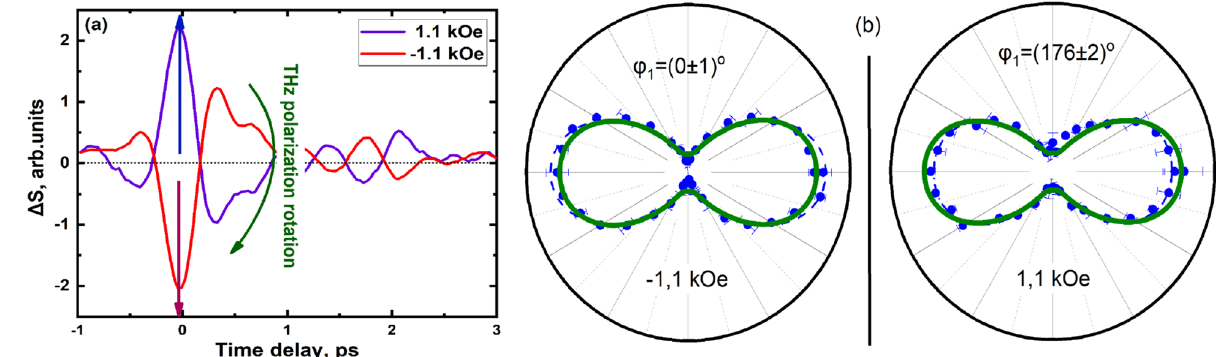
Figure 5. ( a ) Time-domain profile of the THz signal generated in the “easy axis” geometry; ( b ) angular diagram of the THz signal detected at variable orientations of the polarizer for different two values of the magnetic field in the “easy axis” geometry. Blue dashed lines are fits to data by Eq. (S4) with ϕ 1 as fitting parameter. By the olive lines, the “ideal” diagrams for 180° rotation are shown.